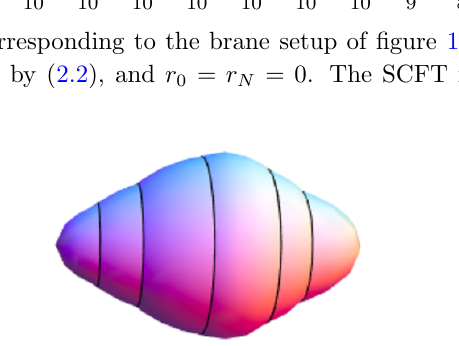
Figure 1. Brane con(cid:12)gurations and quivers for SU gauge and (cid:13)avor groups.